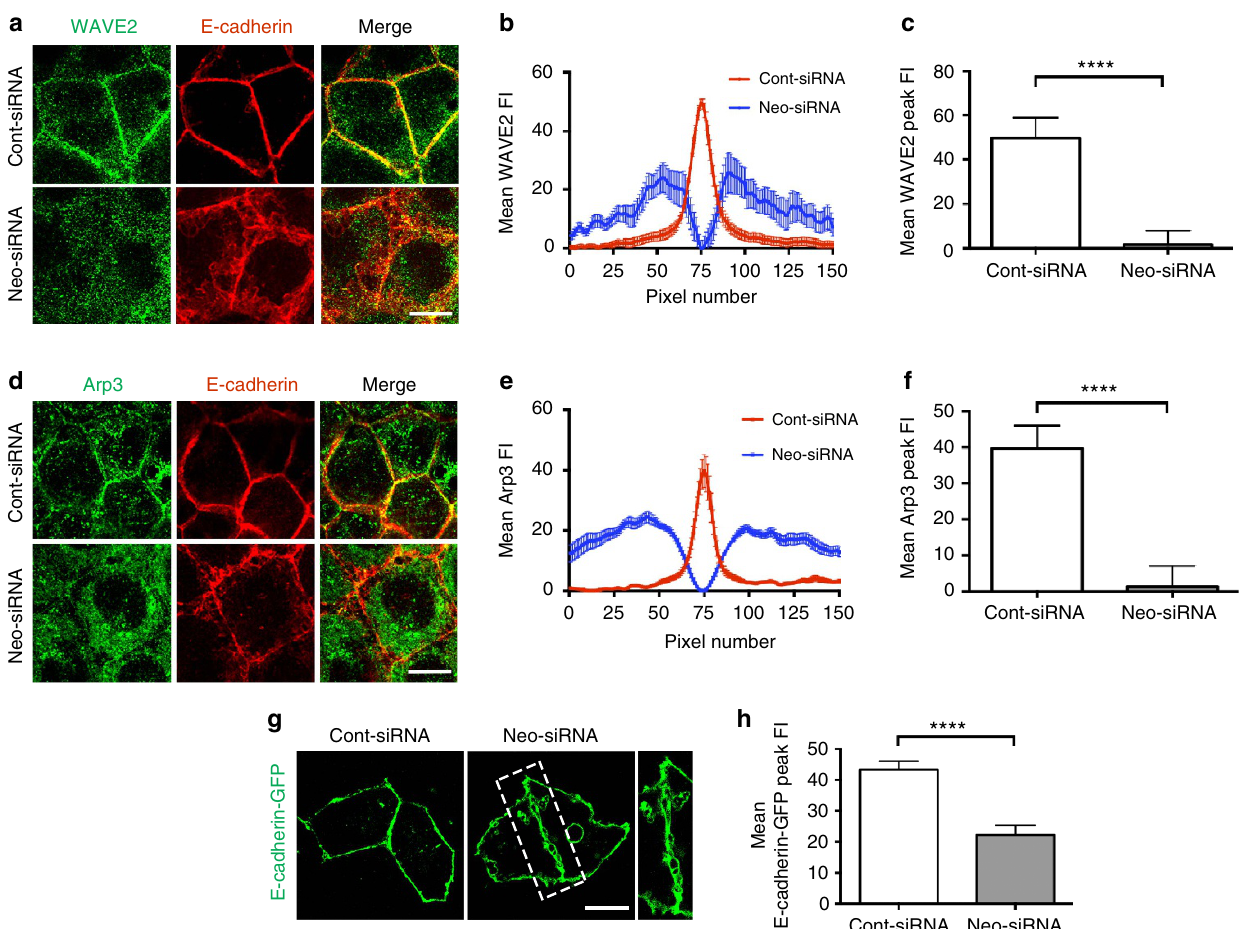
Figure 4 | Neogenin recruits WAVE2 and Arp2/3 to the AJ. ( a ) WAVE2 (green) was not associated with Ecad (red) at the AJ in Neo-siRNA-expressing cells. Line-scan analysis: ( b ) mean WAVE2 fluorescence intensity (FI) across AJs and ( c ) mean WAVE2 peak FI at junctions. ( d ) Arp3 (green) was not associated with Ecad (red) at the AJ. Line-scan analysis: ( e ) mean Arp3 FI across AJs and ( f ) mean Arp3 peak FI at junctions. ( g ) Coexpression of full- length Ecad (Ecad-GFP) did not rescue the Neo-siRNA phenotype. ( h ) Line-scan analysis: mean Ecad peak FI in cells coexpressing Neo-siRNA and Ecad- GFP. ( b , c , e , f , h ) n ¼ 150 junctions, mean ± s.e.m., **** P o 0.0001, Student’s t -test. Scale bars, 7 m m ( a , d ); 15 m m ( g